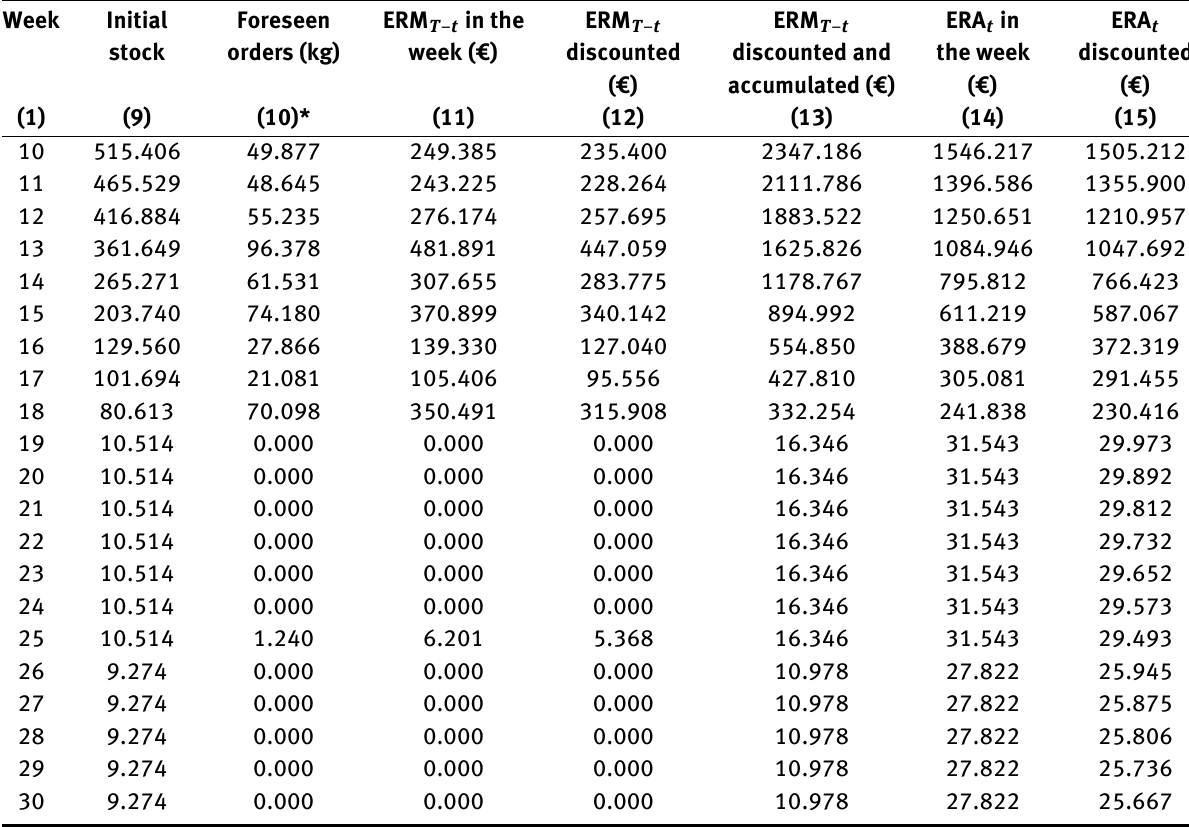
Table 4: Snap values resulting from one of the simulator iterations